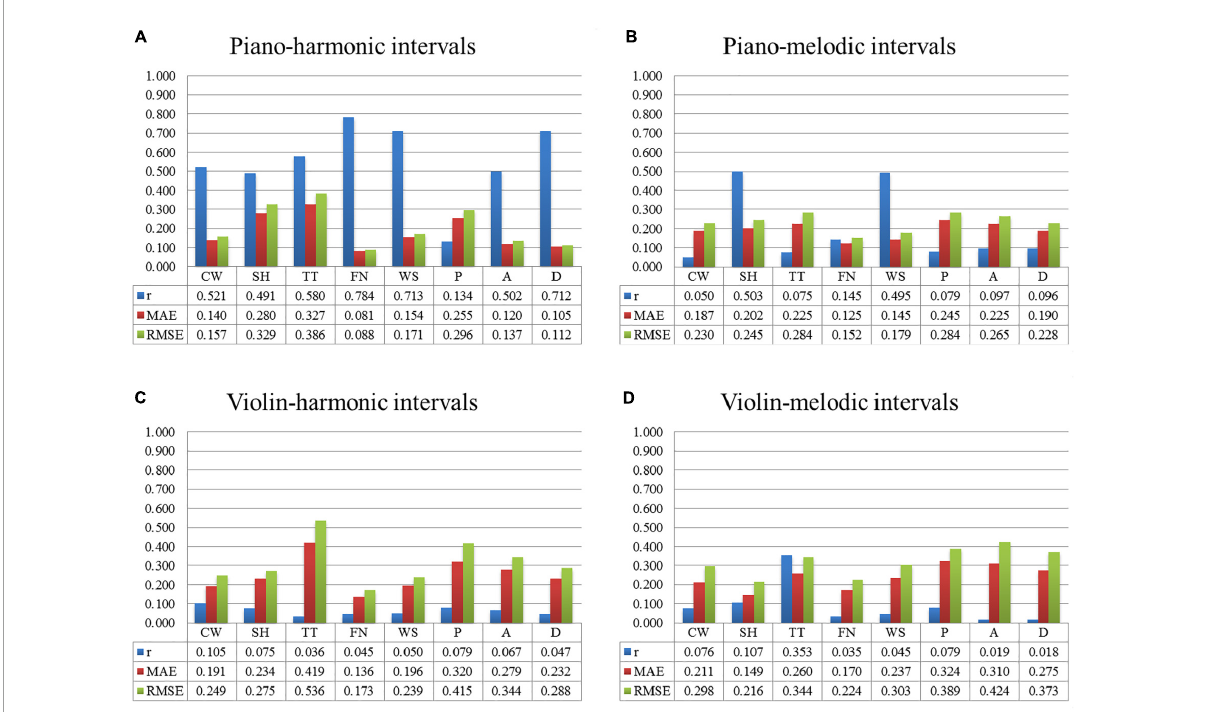
FIGURE6 The prediction results of each multi-color perceptual attribute by the interval consonance index. (A) The predication results by piano-harmonic intervals. (B) The predication results by piano-melodic intervals. (C) The predication results by violin-harmonic intervals. (D) The predication results by violin-melodic